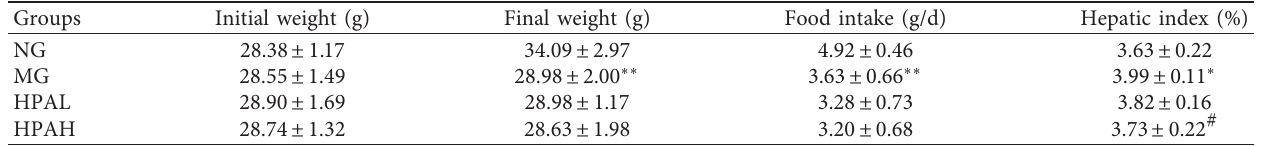
Table 2: Effects of AP and AS on body weight, food intake, and liver index of mice.